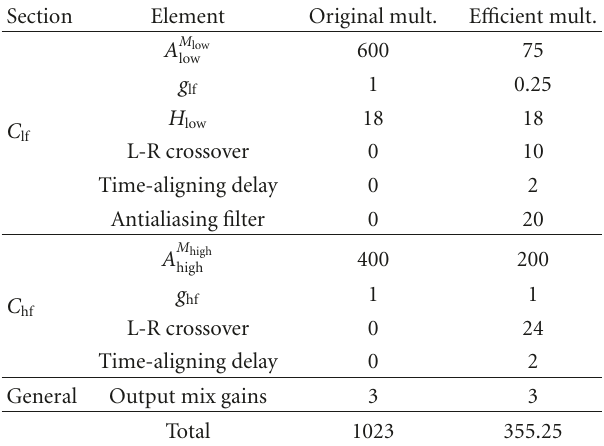
Table 2: Multiplications required (per sample period at full f s ) for e ff ect structure, broken into sections and shown with and without the suggested